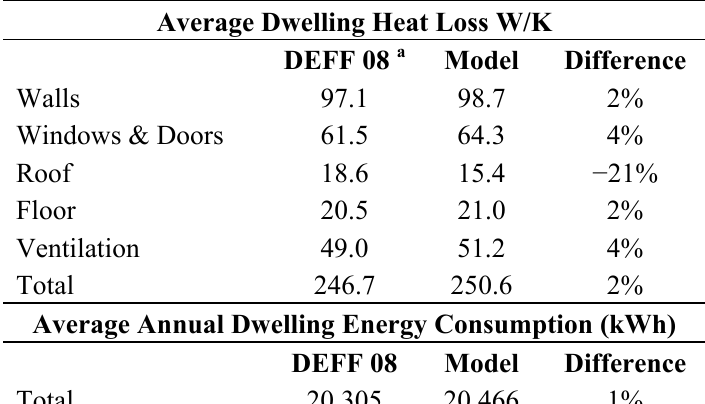
Table 3. Model validation